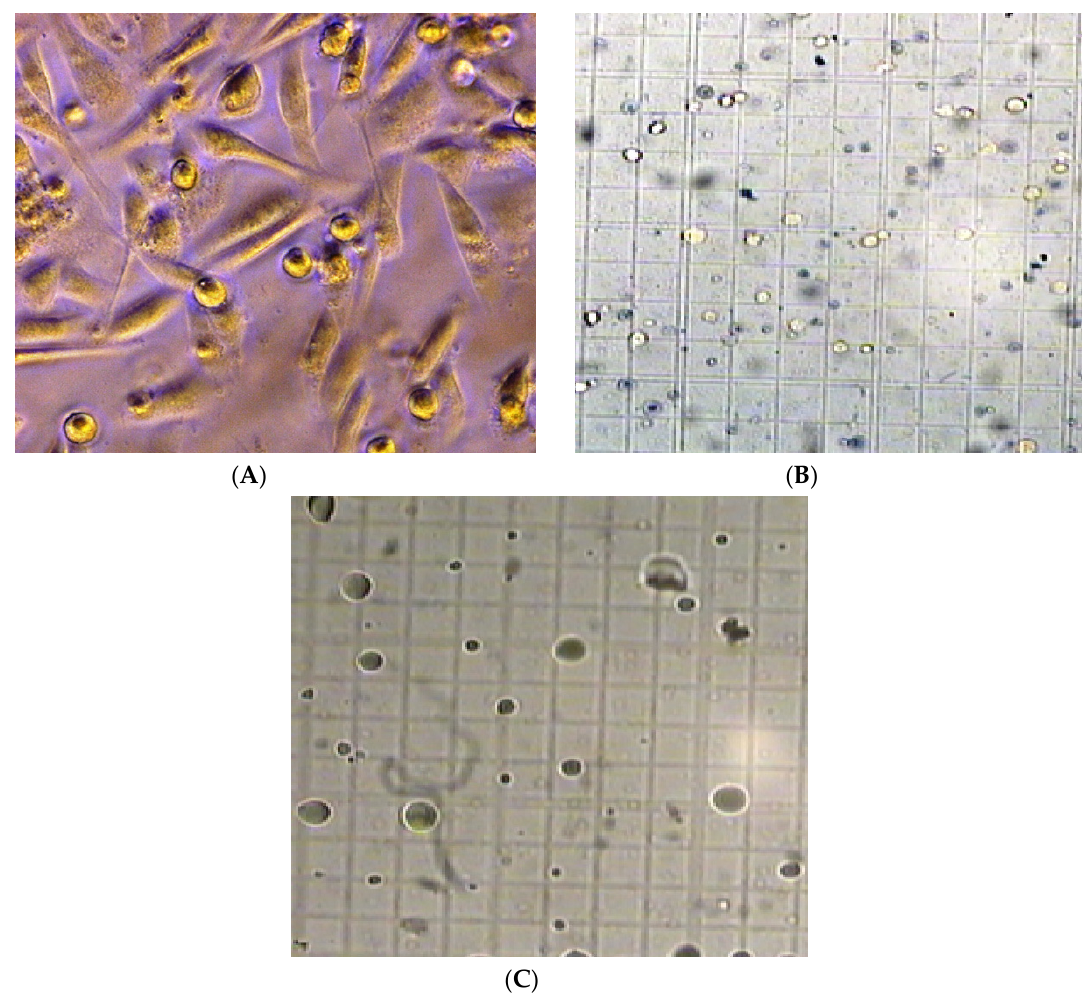
Figure 4. ( A ) Trypan blue dye exclusion staining: the human lung carcinoma cell line ‐ A549 stained with Trypan blue staining immediately upon addition of A. mexicana extracts; ( B ) Trypan blue dye exclusion staining: The human lung carcinoma cell line ‐ A549 treated with 300 μ g A. mexicana leaf extract. Trypan blue staining performed after 72 h of incubation. The black dots denote dead necrotic mass. Hollows and diffused staining denote complete lysis and cell masses in the process of lysis; and ( C ) Trypan blue dye exclusion staining: the human lung carcinoma cell line ‐ A549 treated with 300 μ g A. mexicana stem extract. Trypan blue staining performed after 72 h of incubation. The black dots denote dead necrotic mass. Hollows and diffused staining denote complete lysis and cell masses in the process of lysis. Images shown used 100× magnification.